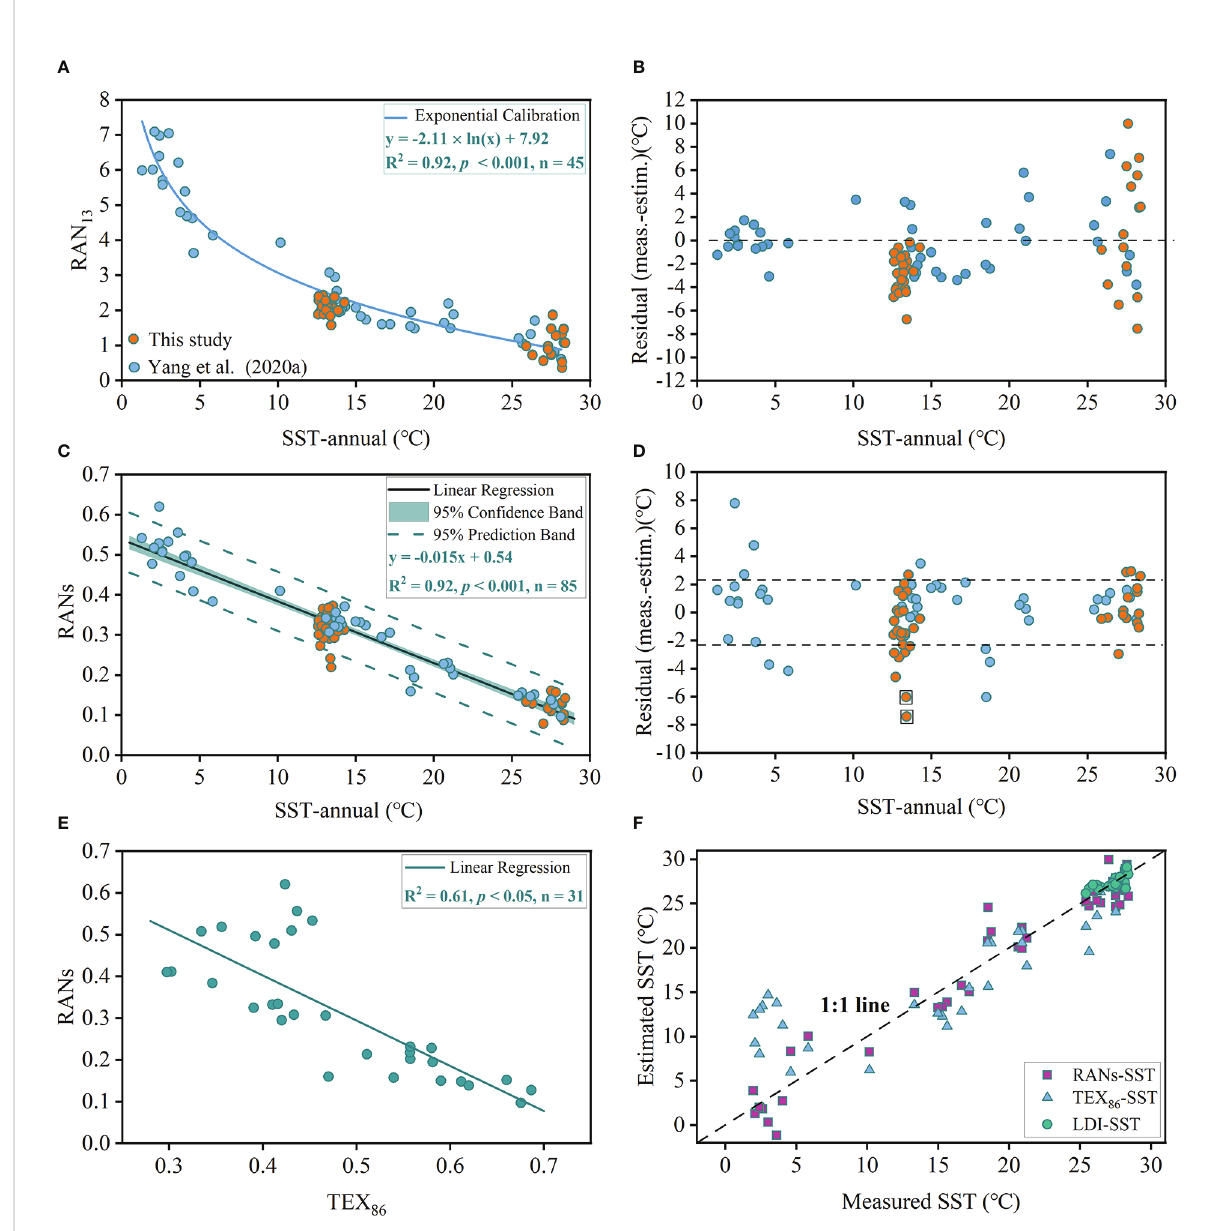
FIGURE 8 (A) Cross plot showing linear relationship between RAN 13 and annual mean SSTs. The nonlinear regression equation is derived from Yang et al. (2020a) and the data used for fi tting do not include 40 samples in this study. (B) The residual values between satellite and RAN 13 estimated SSTs. (C) Cross plot showing linear relationship between RANs and annual mean SSTs. (D) The residual values between satellite and RANs estimated SSTs. Dashed lines denote the RMSE (2.3°C). Two samples in square frame are from the mouth of the Yellow River. (E) The linear relationship between RANs and TEX 86 . (F) The relationship between the TEX 86 derived SSTs, LDI derived SSTs and RANs-based SSTs compared with measured annual SSTs. TEX 86 and LDI data are from Yang et al. (2020a) and Yang et al. (2020b),